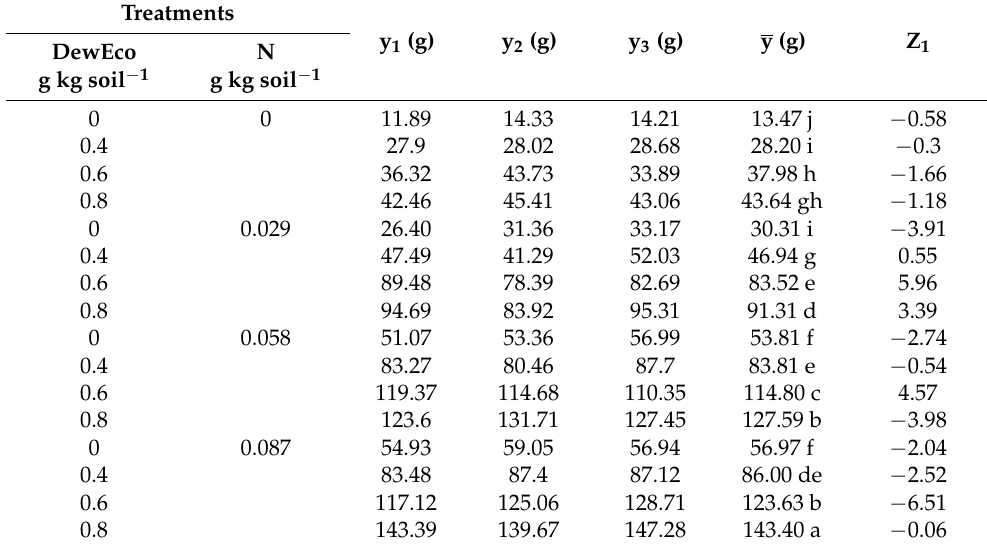
Table 3. Z values calculated from biomass.